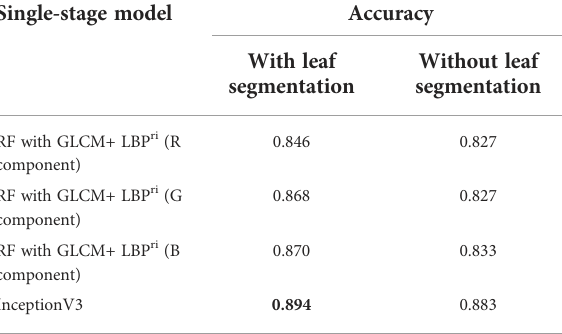
TABLE 3 Identi fi cation accuracies of single-stage models (for identifying fi ve categories of leaf diseases) with or without leaf